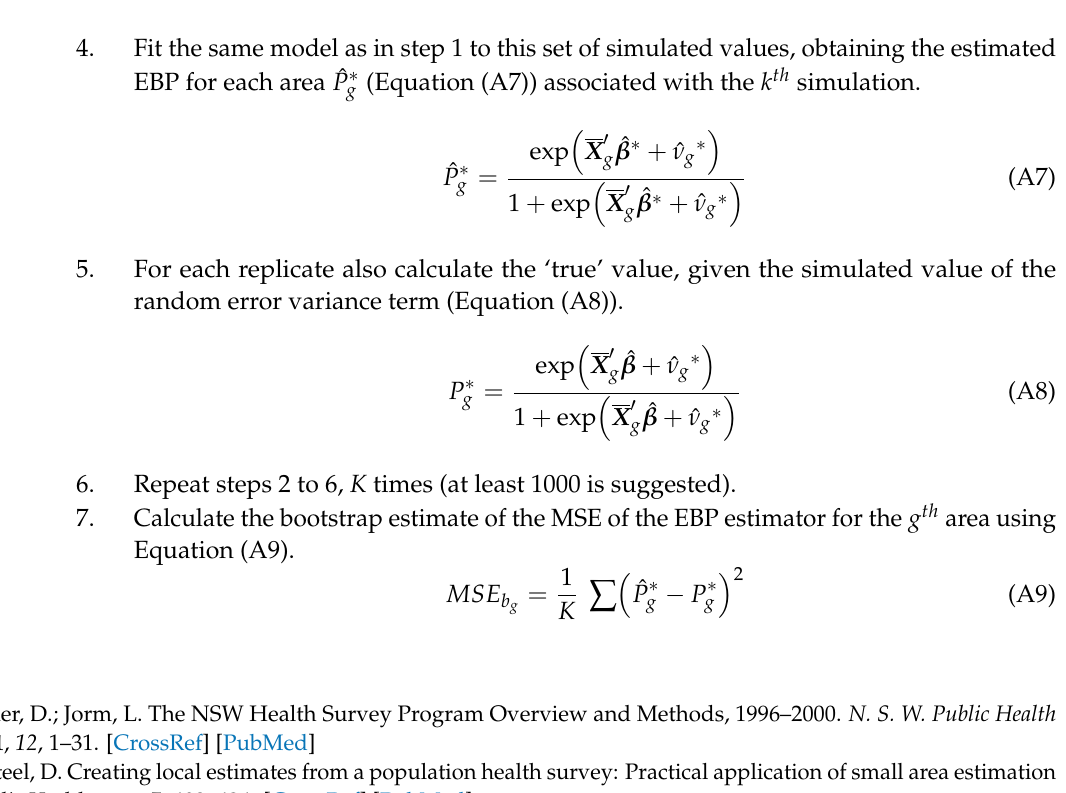
Fit the same model as in step 1 to this set of simulated values, obtaining the estimated EBP for each area ˆ P ∗ (Equation (A7)) associated with the k th simulation. g